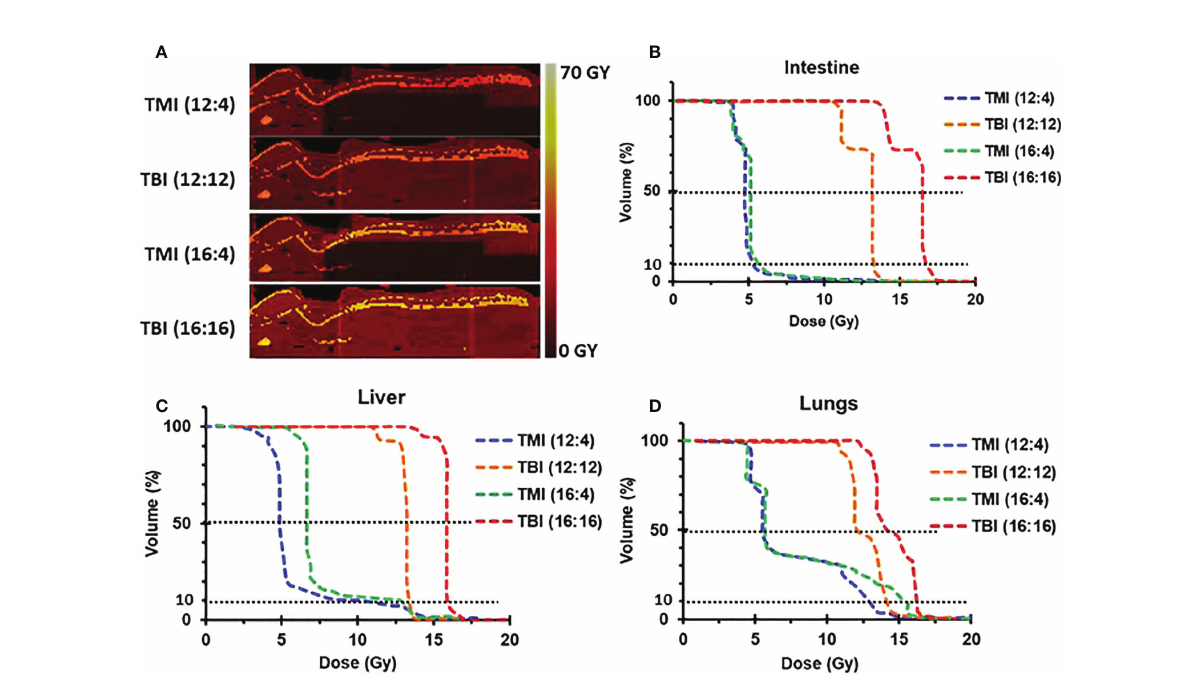
FIGURE 1 TMI vs. TBI strategy. Dose distribution for different radiation treatment regimens. (A) Radiation dose distribution of imaged-guided TMI or TBI strategy. Color painting of radiation dose 0-60 Gy. TMI showed 40-75% less radiation dose in liver, lung, and gut than TBI. (B) Dose volume histogram (DVH) of intestine. (C) DVH of liver. (D) DVH of lungs.